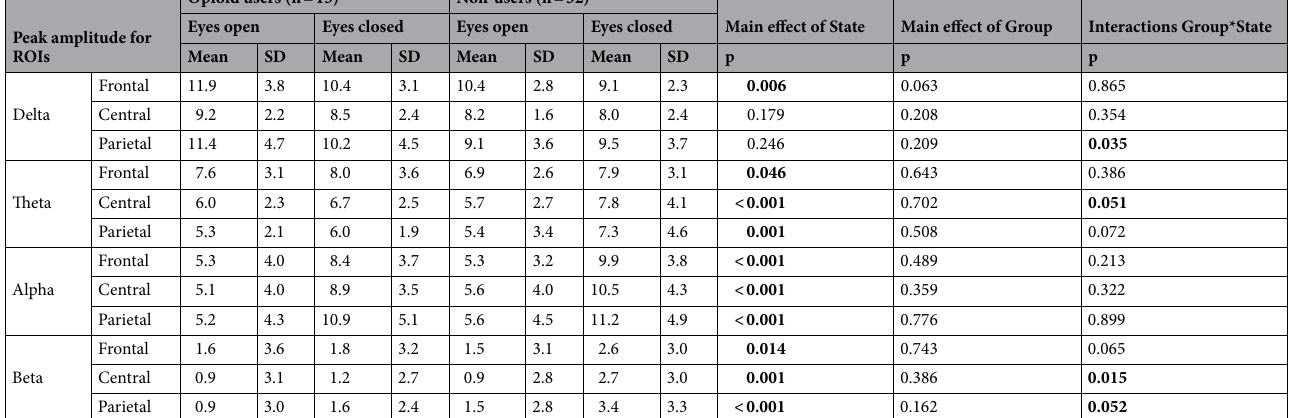
Table 2. Comparisons between Group (opioid users and non-users) and State (eyes open [EO] and eyes closed [EC]) for peak amplitude of SPD for each region of interest and frequency band (total n = 47). Bold values indicates statistically significant effects (P < 0.05) and marginally non-significant effects. P-values are based on univariate analysis of variance (ANOVAs). SD = standard deviation; ROI = region of